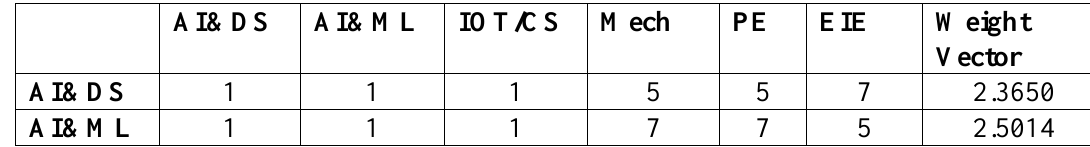
(Freedom to work from 5